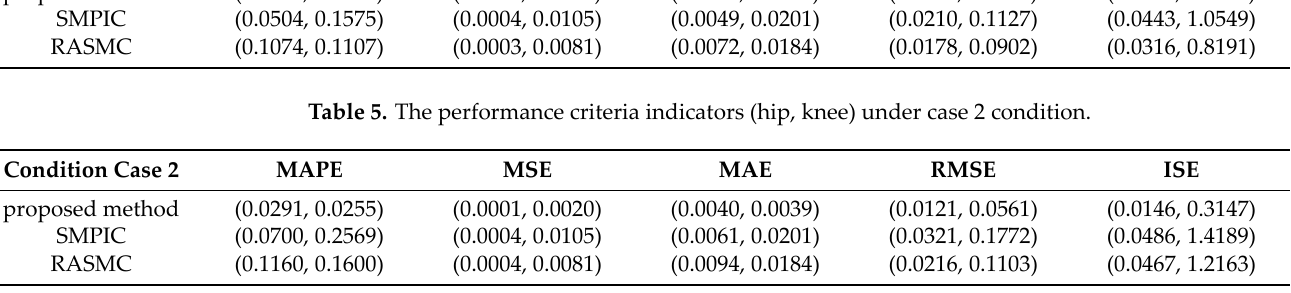
Table 4. The performance criteria indicators (hip, knee) under case 1 condition.